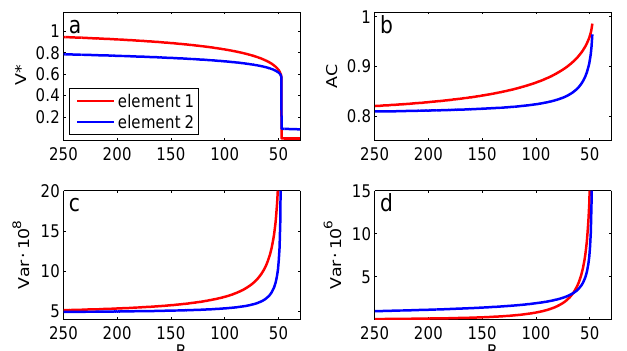
Fig. 2. Characteristics of system 1 in dependency on parameter B. (a) Equilibrium vegetation cover, (b) autocorrelation (lag 1), (c) variance (additive noise only), (d) variance (multiplicative noise only).